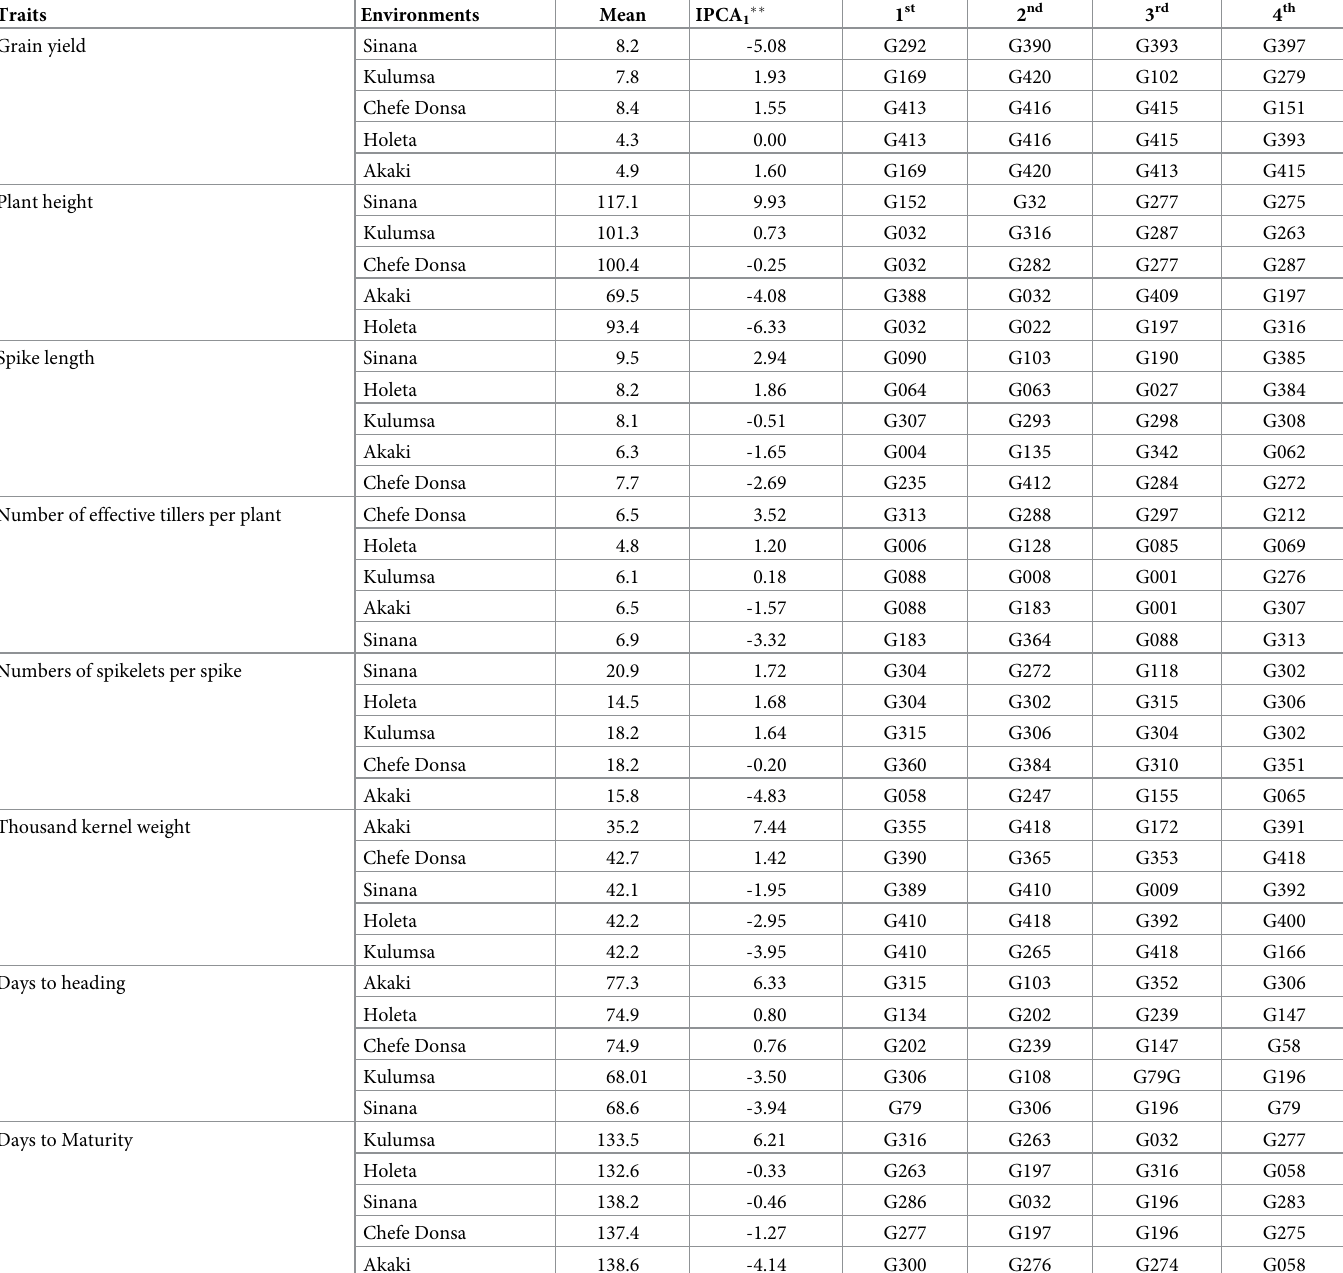
Table 4. Test site-specific mean values, IPCA1 score, and the first four genotypes selected by AMMI for the eight traits: Grain yield (t ha-1), plant height (cm), spike length (cm), number of effective tillers per plant, number of spikelets per spike, thousand kernel weight (g), days to heading and maturity.